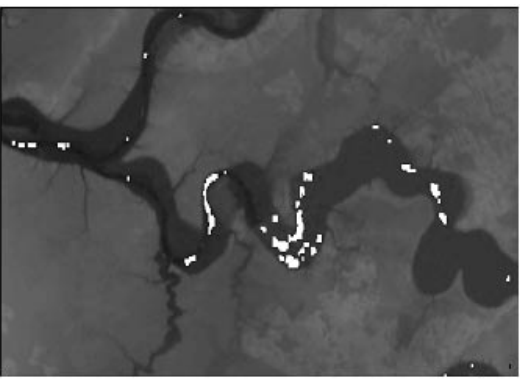
Fig 1. DTM fragment of Nemunas and Neris confluence, created using InSAR method Neišmatuota liko 53,56 km 2 Lietuvos teritorijos. Ši ų vietovi ų